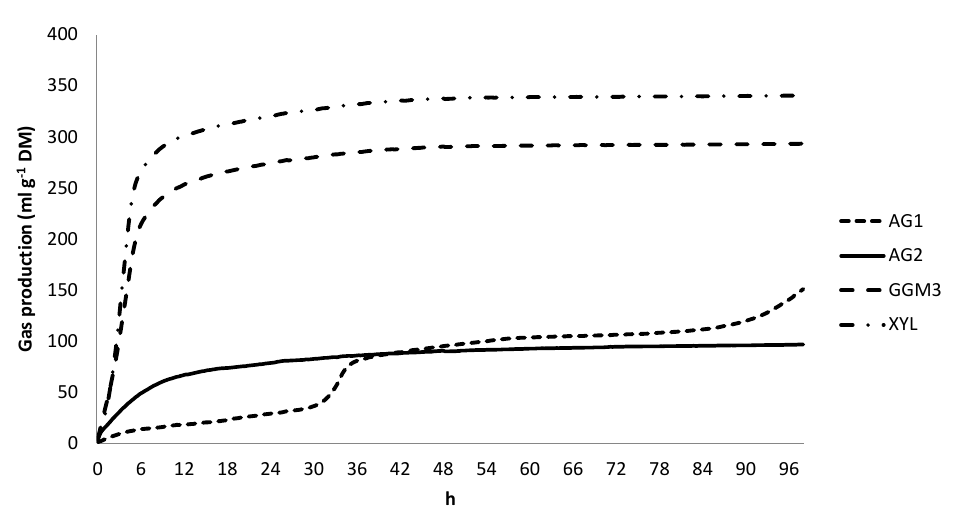
Fig. 1. Typical cumulative in vitro gas production curves in Exp. 1 for galactoglucomannan (GGM3), xylan (XYL) and arabinogalactan (AG1 and